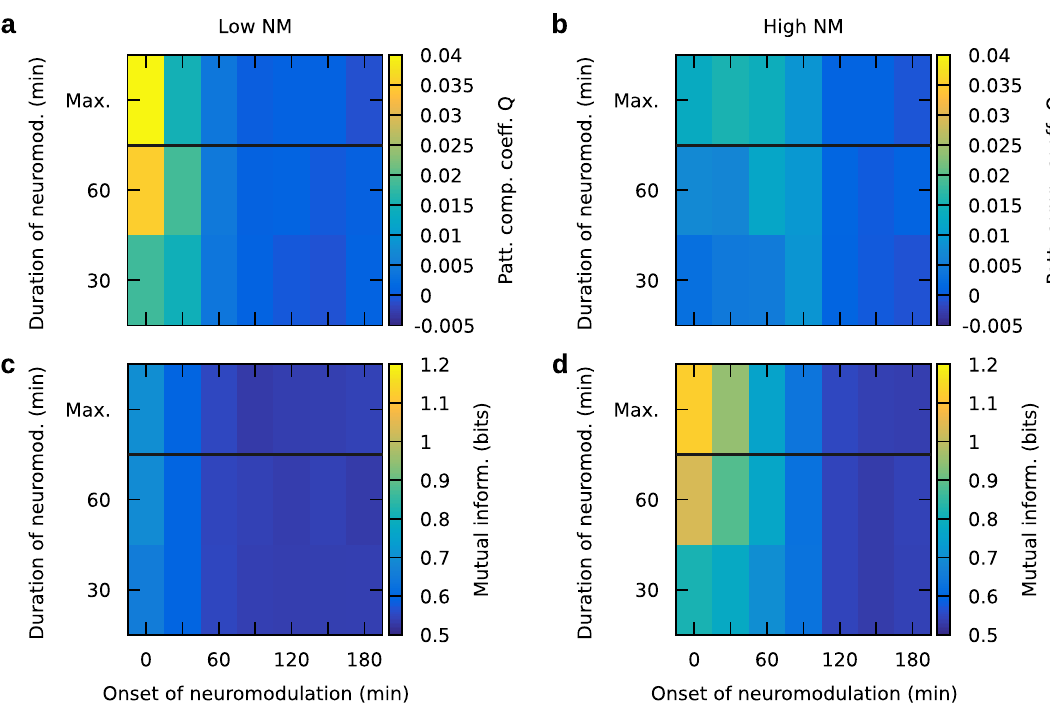
Figure 4. Timing of neuromodulation during consolidation has differential impact on recall of input-defined and self-organized patterns 8 h after learning. ( a ) Low neuromodulation (NM) causes strong recall of an input- defined pattern (measured by Q ) if starting early and lasting long. ( b ) High neuromodulation causes significant recall of an input-defined pattern (measured by Q ) only in a certain regime (also cf. Fig. 3b). ( c , d ) For self- organized patterns measured by mutual information, both low and high neuromodulation cause better recall if starting early and lasting long. Data were averaged over 50 networks. Frequency of the learning